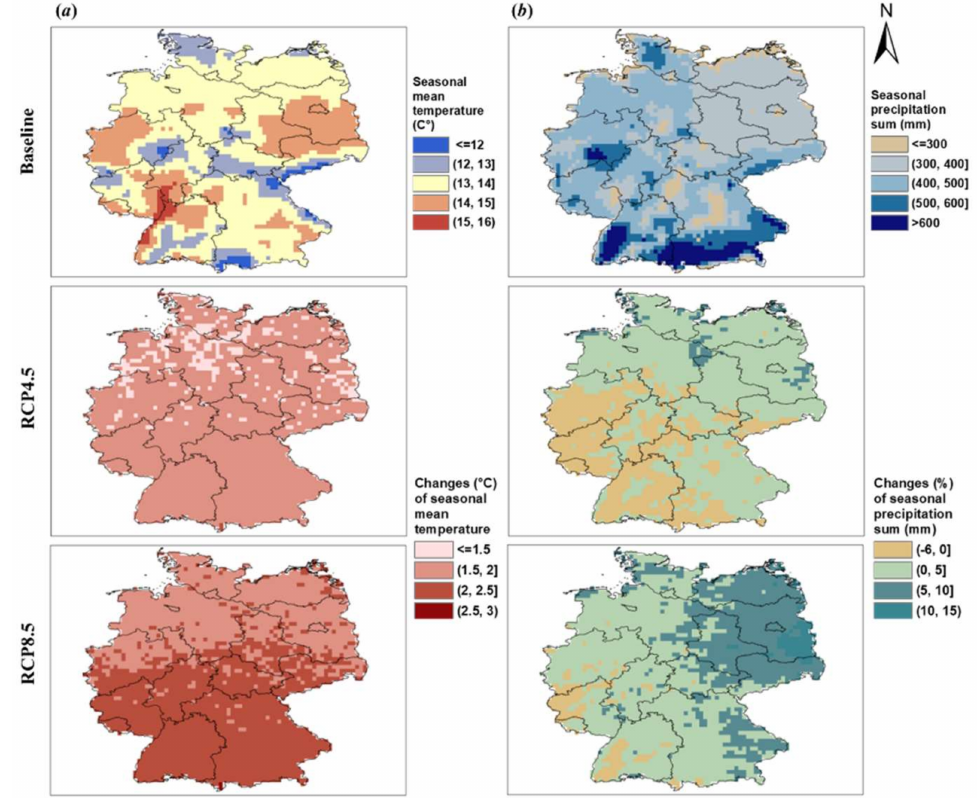
Figure 2. Ensemble median of climate model projections for the mean seasonal (April–October) ( a ) average temperature ( ◦ C) and ( b ) precipitation sum (mm) in the baseline period (1976–2005) and respective mean changes in the future period (2041–2070) under RCP4.5 and